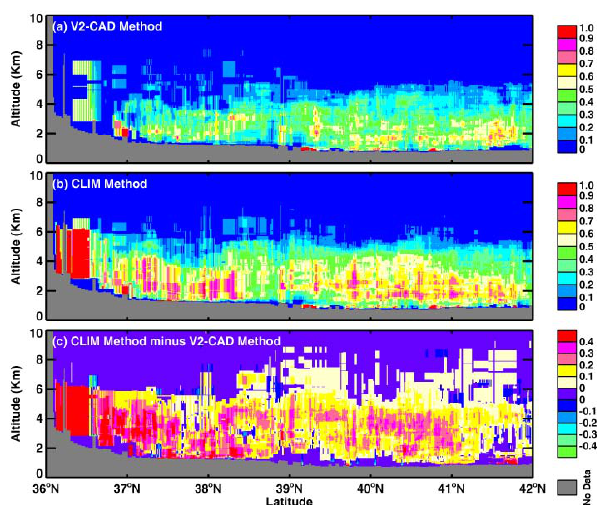
Fig. 9. Latitude mean vertical distributions of dust layer occurrence from CALIPSO observations by V2-CAD method (a) , CLIM (b) , and CLIM minus V2-CAD (c) over Taklamakan desert for eleva- tions below 3km during spring 2008.